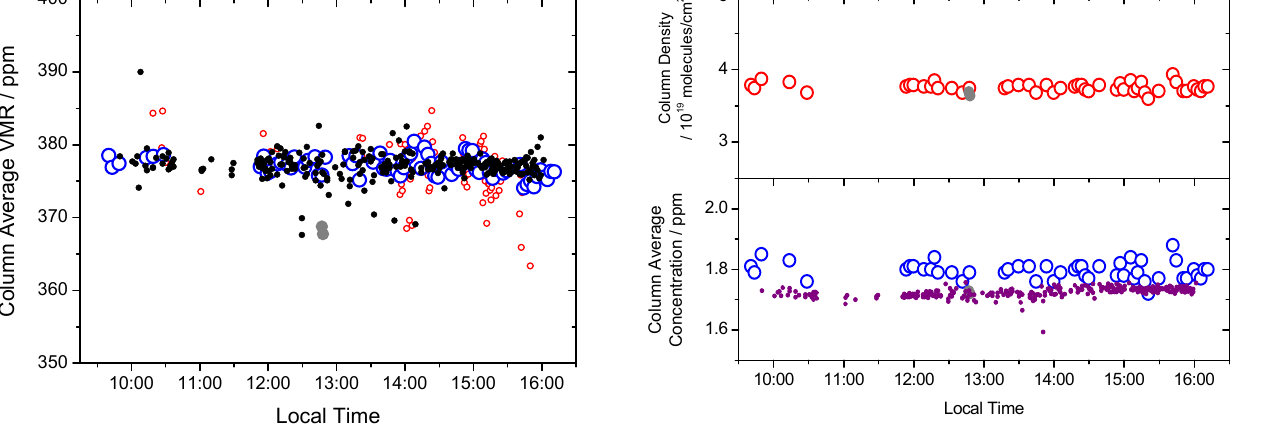
Fig. 9 Fig. 9. Time series of column density and column average VMRs of CH 4 . OSA: large open circles; FTS-GFIT: small solid circles; GOSAT: gray solid circles. On 26 August